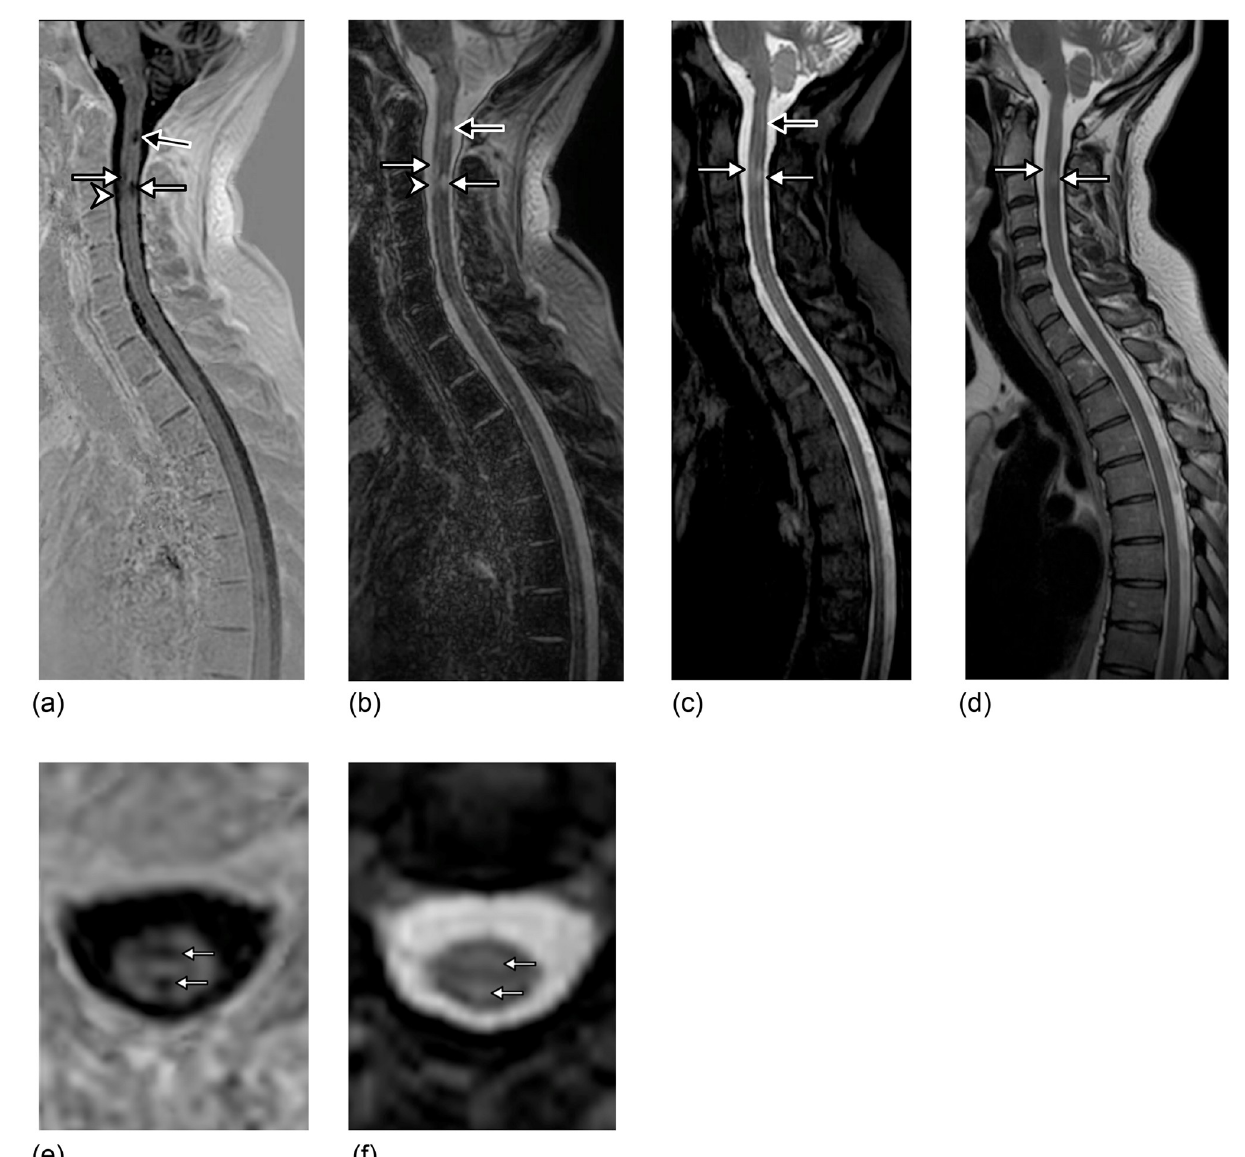
Fig 1. A 32 year-old woman with relapsing-remitting multiple sclerosis. 3D-Fast Gray Matter Acquisition with Phase Sensitive Inversion Recovery (3D-FGAPSIR) real-corrected (a) and second magnitude (b) images reformatted in the sagittal plane, providing more accurate detection and delineation of one anterior and one posterior C3 lesions (white arrow) and showing one supplementary distinct anterior C3 lesion (arrowhead) as compared to 3D-Short-Tau Inversion Recovery reformatted in the sagittal plane (c) and sagittal T2-weighted imaging (d). 3D-FGAPSIR also showing a posterior C2 lesion (black arrow) with a high reader-reported confidence, high delineation and high conspicuity, whereas the same lesion is hardly visible on the conventional dataset. 3D-FGAPSIR real-corrected image reformatted in the axial plane (e) localizing and delineating more precisely the C3 lesions as compared to 3D-STIR reformatted in the axial plane